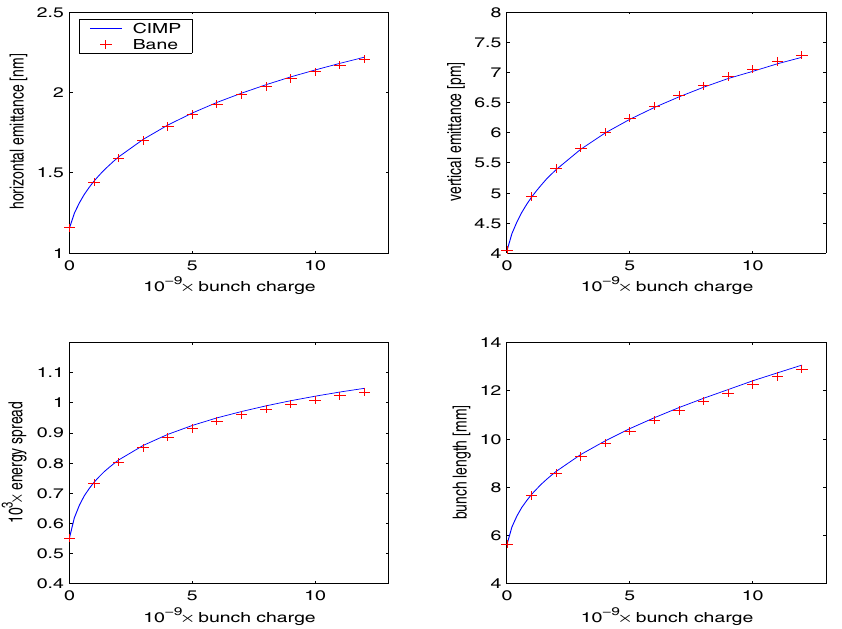
FIG. 1. (Color) Equilibrium transverse emittances, relative energy spread, and rms bunch length vs bunch charge for the ATF prototype damping